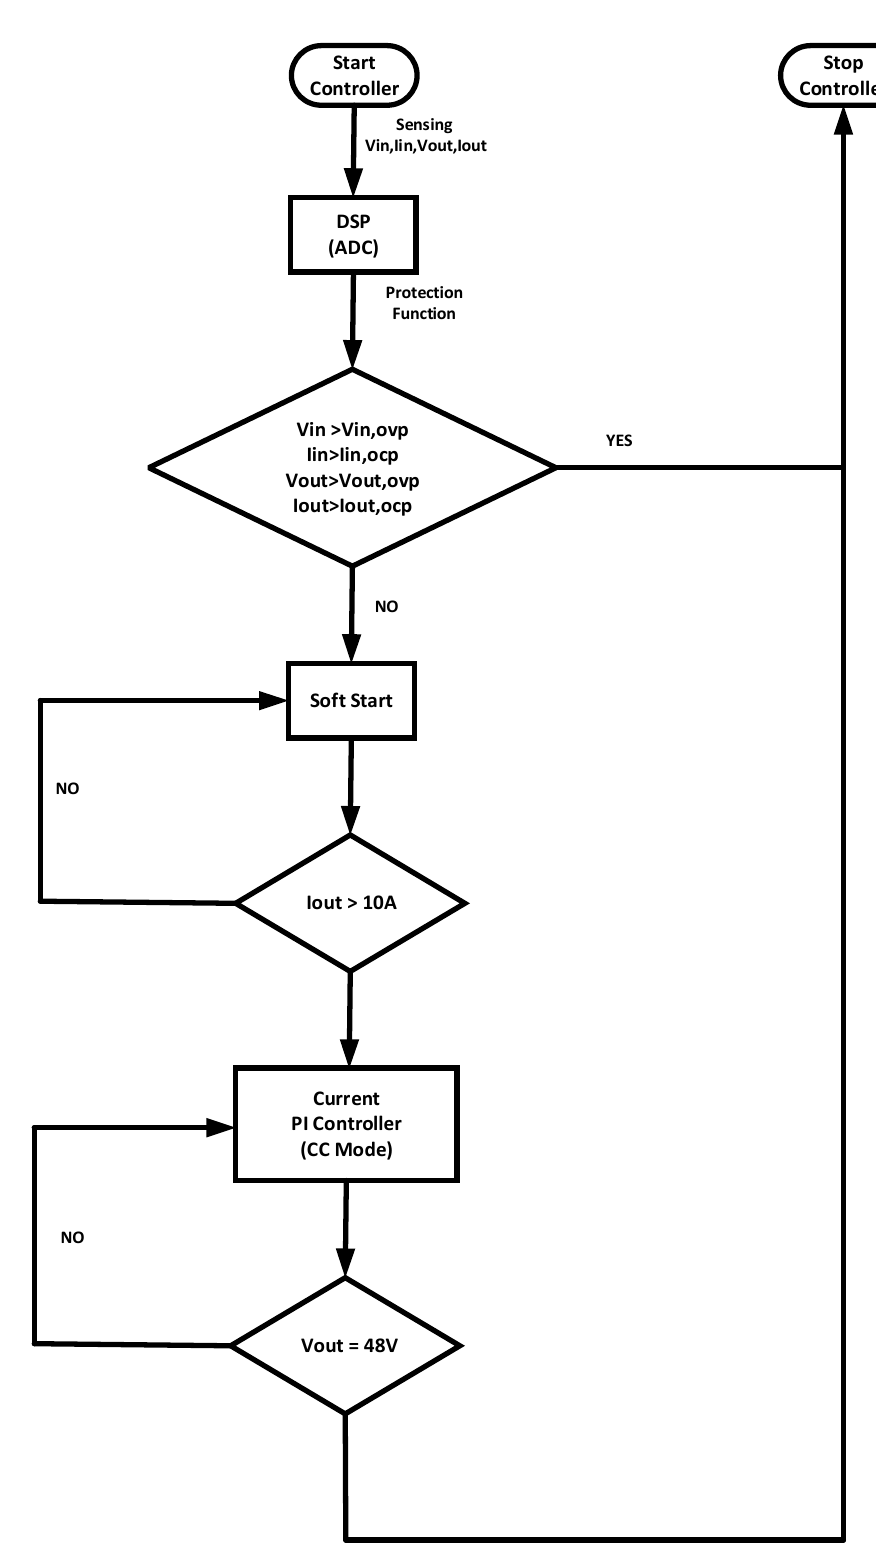
Figure 10. The proposed algorithm of SC (Super-Capacitor).